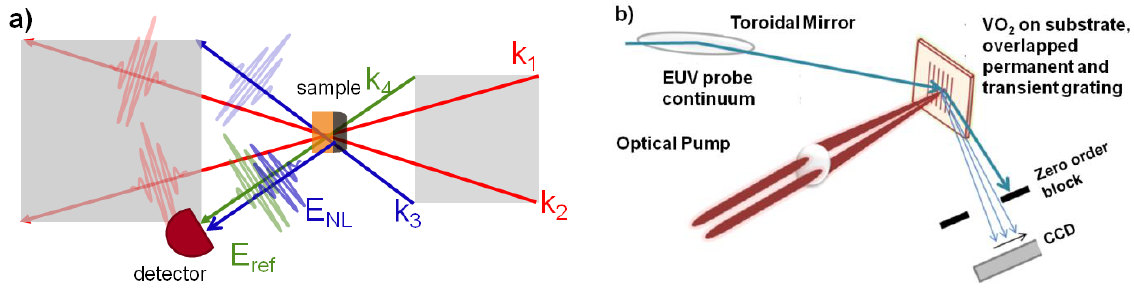
Figure 1. ( a ) General transient grating scheme. Pulses 1 and 2 hit the sample simultaneously with different wavevectors k 1 and k 2 , thus creating a transient